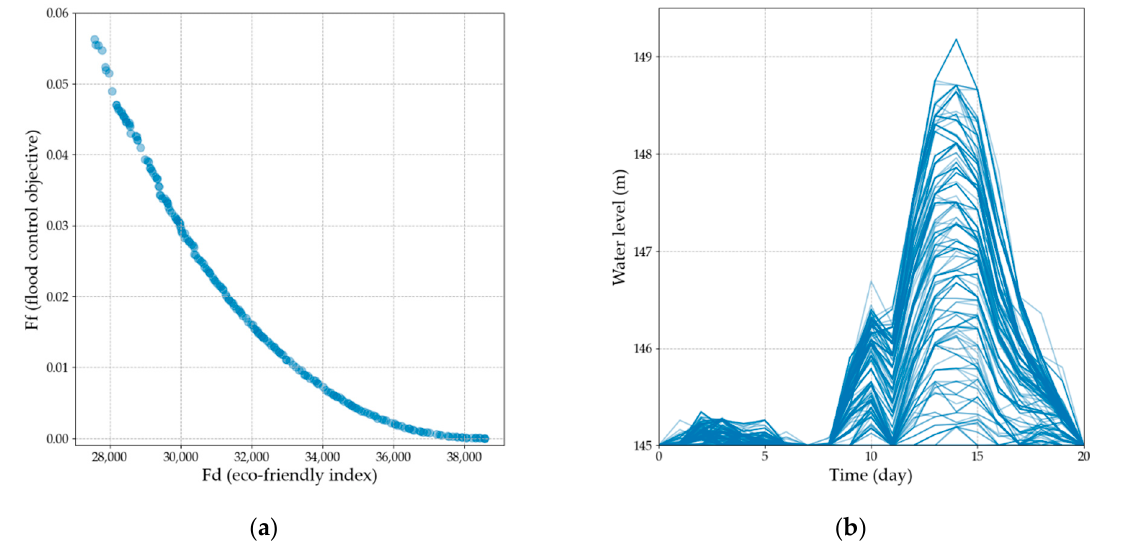
Figure 5. Output of non-dominated sorting genetic algorithm II (NSGA-II) in the objective and decision spaces: ( a ) the trade-offs between the eco-friendly objective and flood control target in objective space; ( b ) the corresponding reservoir operation processes in decision space.